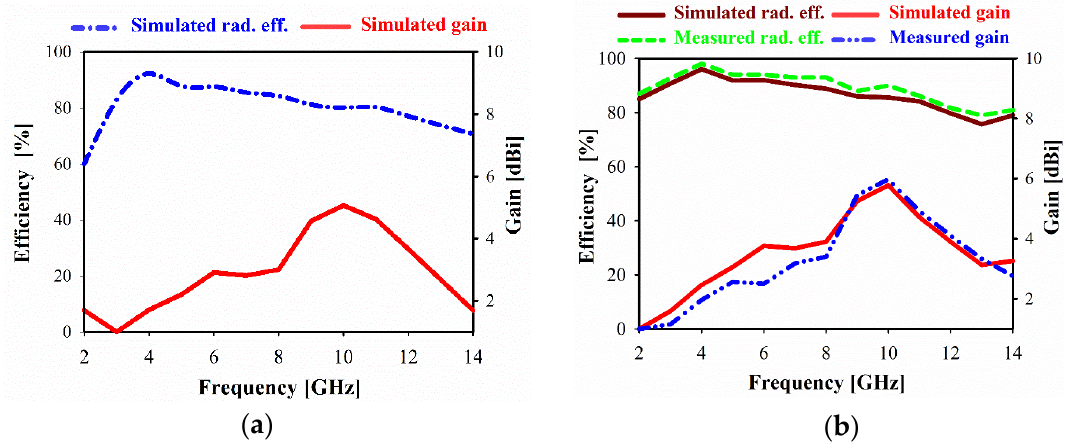
Figure 15. The proposed antenna gains and radiation efficiency over frequency ( a ) without MTM and ( b ) with MTM.